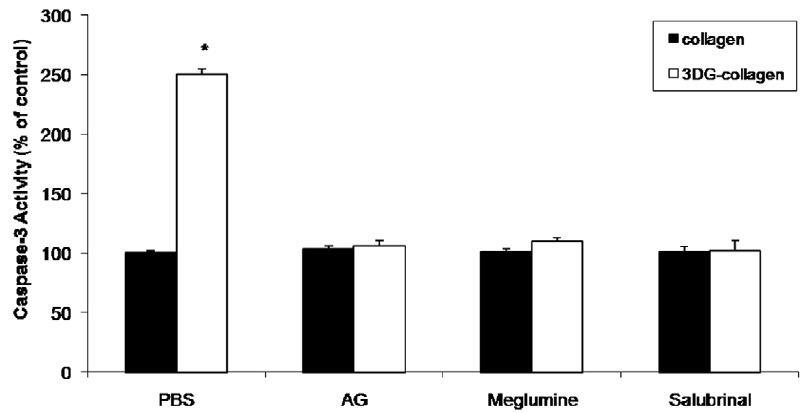
Figure 1. Induction of caspase-3 activity by 3DG-collagen is dependent on ER stress. Fibroblasts were cultured on native collagen or 3DG- collagen and treated with or without 5 mM AG, 40 mM meglumine, or 40 m M salubrinal for 24 h. 100 m g of whole cell lysate was assayed for caspase- 3 activity according to the protocol from Caspase-3 Colorimetric Correlate Assay. All samples were performed in triplicate and normalized to the control samples. All comparisons are made against collagen treated with PBS. Data are mean 6 SD (n=3), *P , 0.0002.